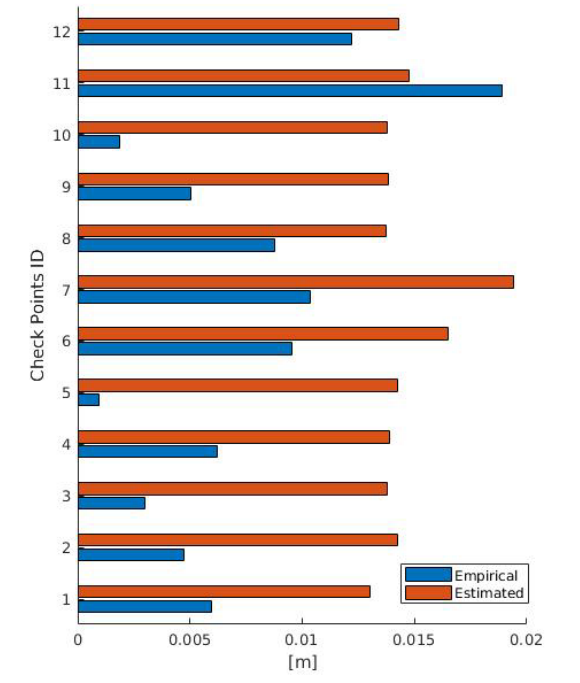
Figure 7. Empirical deviation and theoretical a priori rms